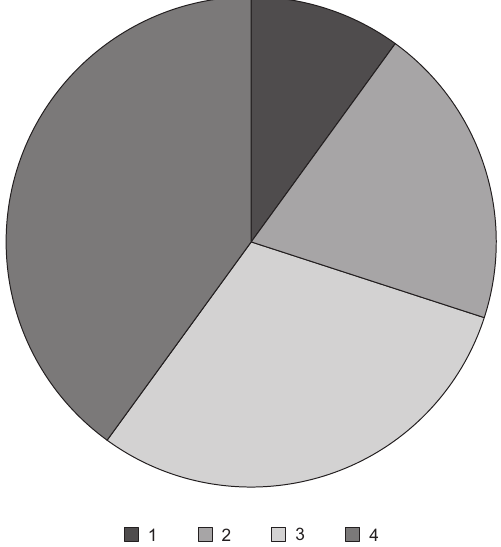
Fig. 4. Target areas of the emigrants from Wrocław (1 – the first ring of the suburban municipalities, 2 – the second ring of the suburban municipalities, 3 – other municipalities in Dolnośląskie Voivodeship, 4 – other municipalities in the country).